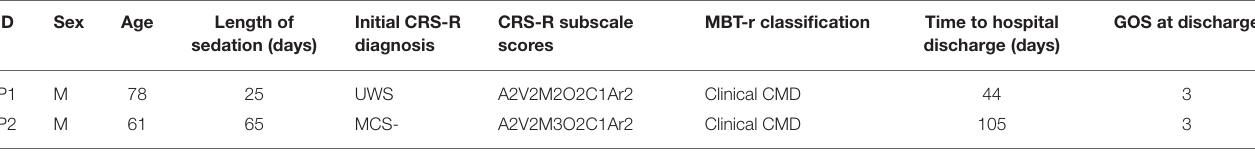
TABLE 1 | Patient demographics, clinical characteristics, and outcomes.